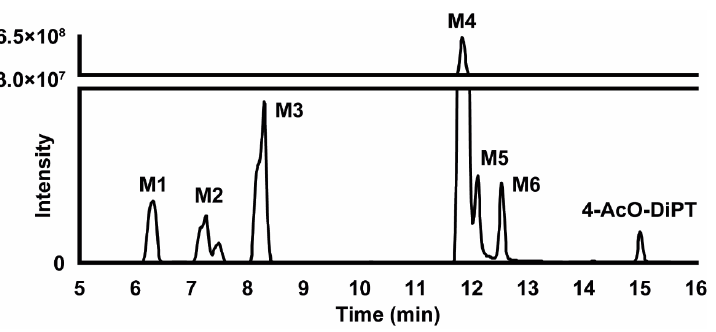
Figure 3. Extracted-ion chromatogram of 4-AcO-DiPT and metabolites in positive-ionization mode obtained after 3 h incubation with human hepatocytes. Mass tolerance: 5 ppm; m / z values: 219.1489, 261.1955, 277.1907, 299.1057, 303.2059, 341.1525, and 437.2277.